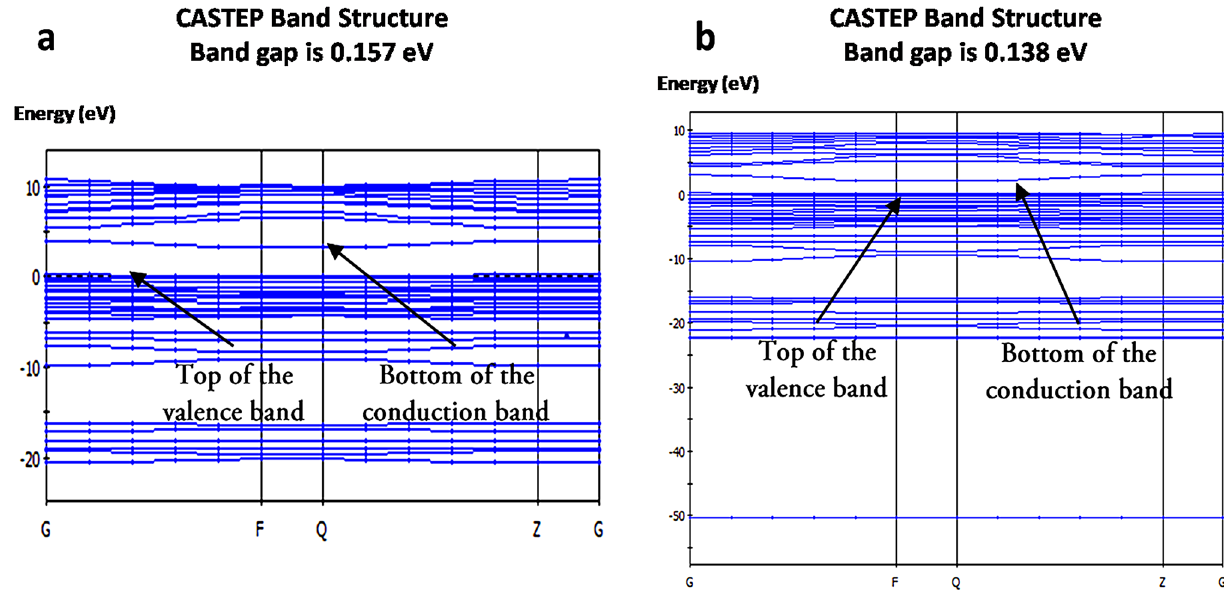
Fig. 9 Band structure of a cleaved SiO 2 (001) surface, b NaOH adsorbed on quartz (001)